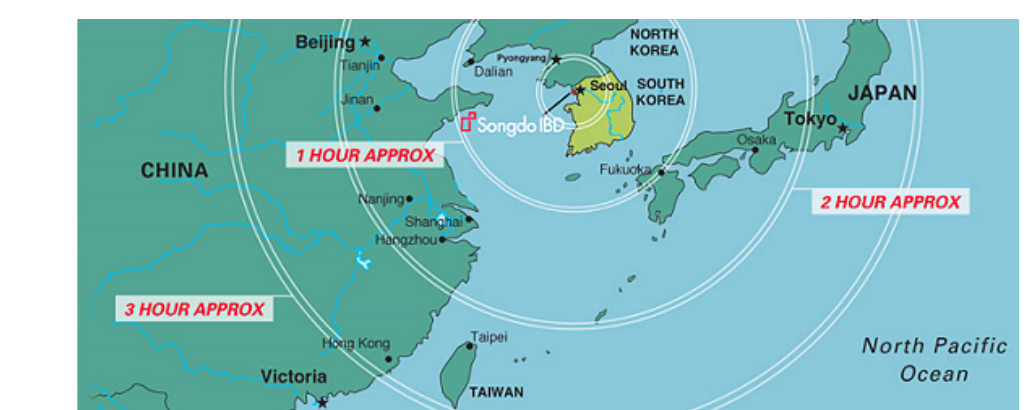
Figure 2. Location Map of Songdo (Songdo IBD from 2015), South Korea. Source: Gale International